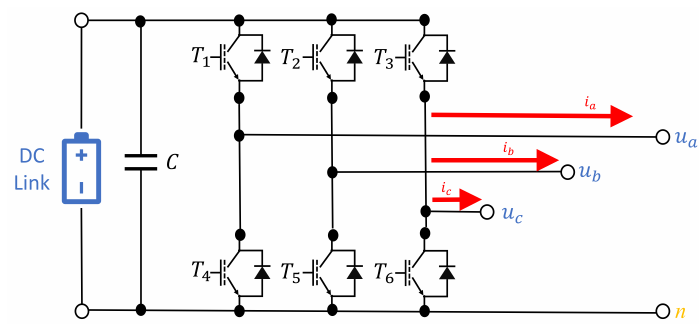
Figure 3. Schematics for used 3-phase